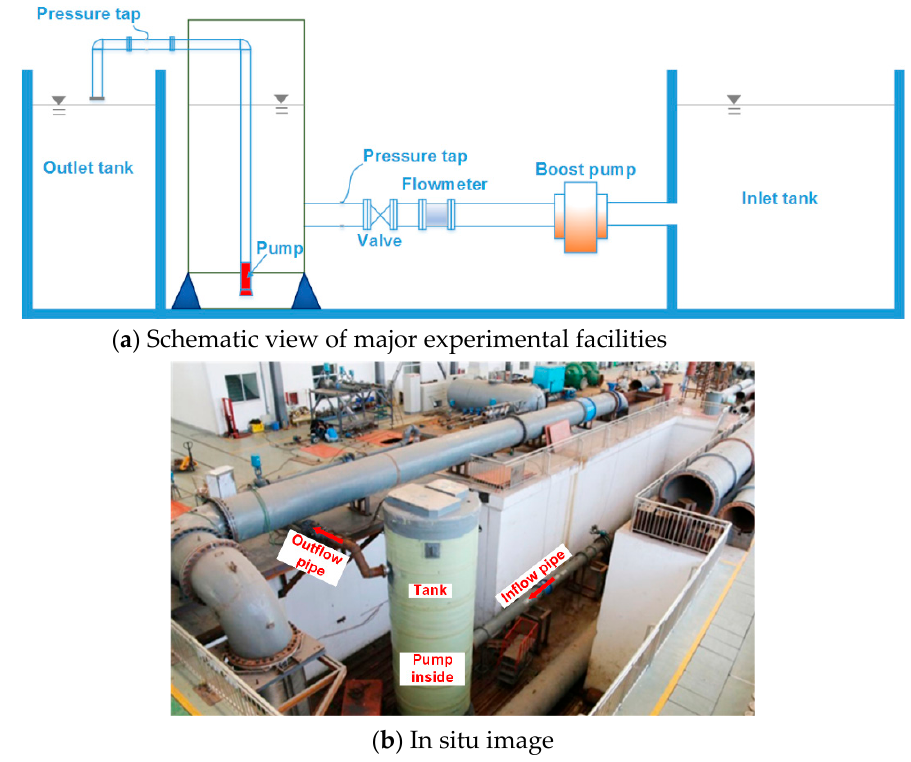
Figure 5. Experimental rig for the prefabricated pumping